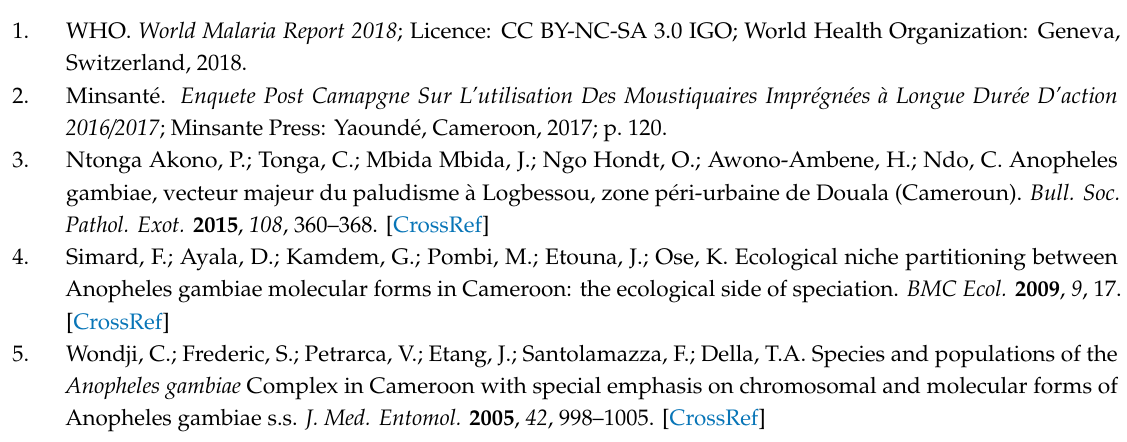
Figure S1: Incidence of resistance alleles in di ff erent populations of An. gambiae mosquitoes, Figure S2: Gene expression analysis in the five populations of the study compared to the two susceptible laboratory strains (Kisumu, Ngousso), Table S1: List of primers and probes used in the present study, Table S2: Relative abundance of each CHC peak, Table S3: Summary of all resistance mechanisms for each of the study’s